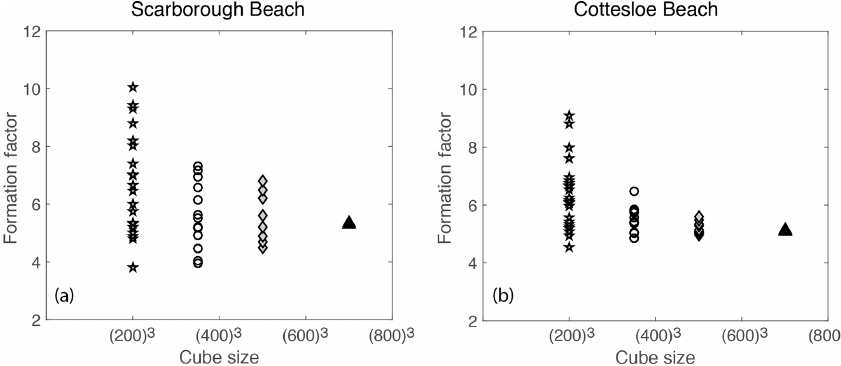
Figure 13. Formation factor against cube sizes for (a) Scarborough Beach and (b) Cottesloe Beach.